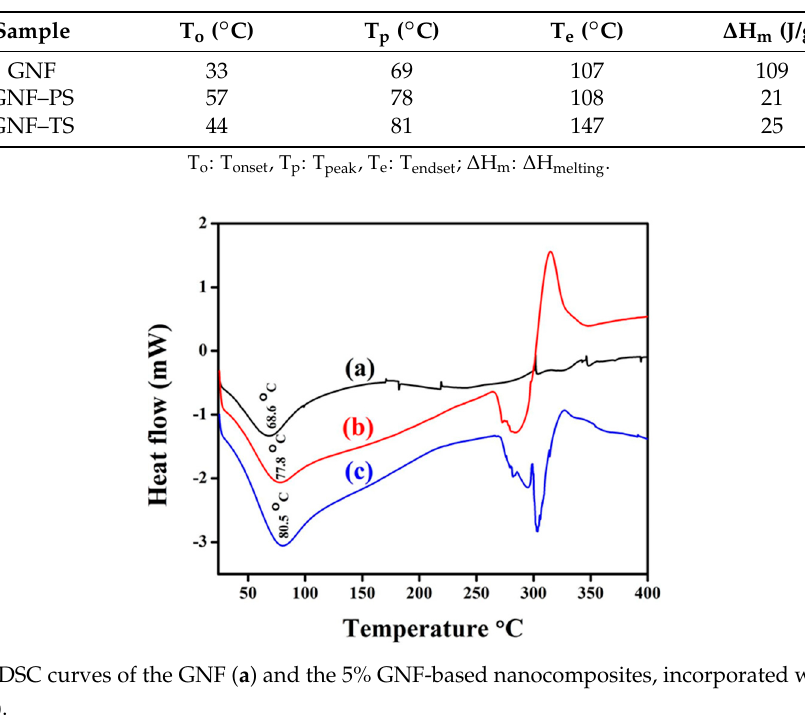
Table 3. Antibacterial activity of the GNF and its PS and TS bionanocomposites, with 5% GNF, in comparison with the control.